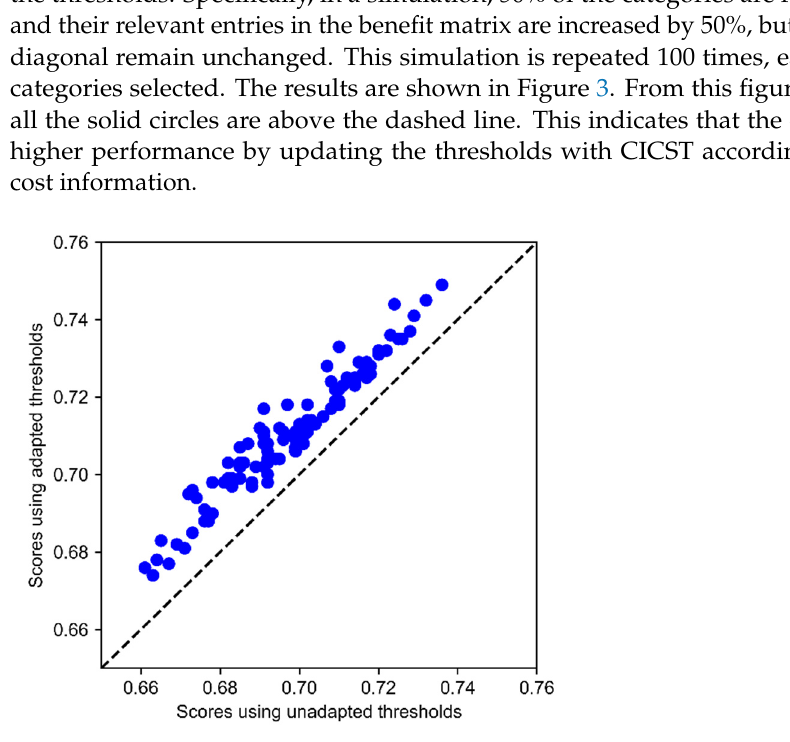
Figure 3. The comparison between scores with and without adaptation to new cost definitions in 100 simulated cost changes. The x -axis indicates the scores that are achieved by CICST using the original cost definitions, while the y -axis indicates the scores that are achieved by CICST using the updated cost definitions. Each solid circle in the figure represents a simulated cost change.